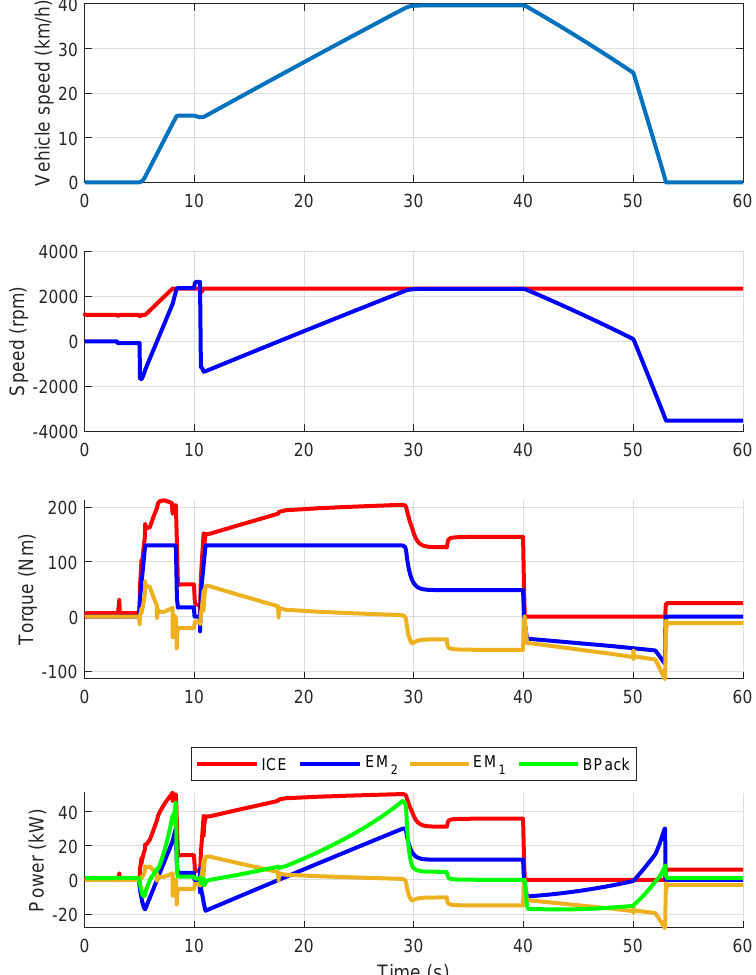
Figure 8. HeCVT 0–40 km/h acceleration test with 10,000 kg trailer and 0% of slope. These tests aimed to verify the capability to provide full power at those different speed conditions under the constant load of the road slope. Moreover, each test was performed with a standing start at the prescribed slope to test the tractor capability to also start moving on the proposed slope condition (Italian traffic laws prescribe that the tractor should at least be able to stand start at 14% with the prescribed trailer load). Results are reported in Table 6. In almost all the work conditions, the HeCVT tractor slightly outperformed the conventional one except for the 5 km/h and 10,000 kg trailer test. In that case, the greater number of possible gear configurations given by a traditional gearbox configuration allowed for greater tractive effort at that specific speed, enabling the conventional ICE to work closer to its max power condition. Only in this special work scenario, the HeCVT system required the use of the boost function of the electric system in order to achieve the prescribed slope. The HeCVT tractor recorded good results at 40 and 15 km/h since its two speed regimes were dimensioned for those vehicle